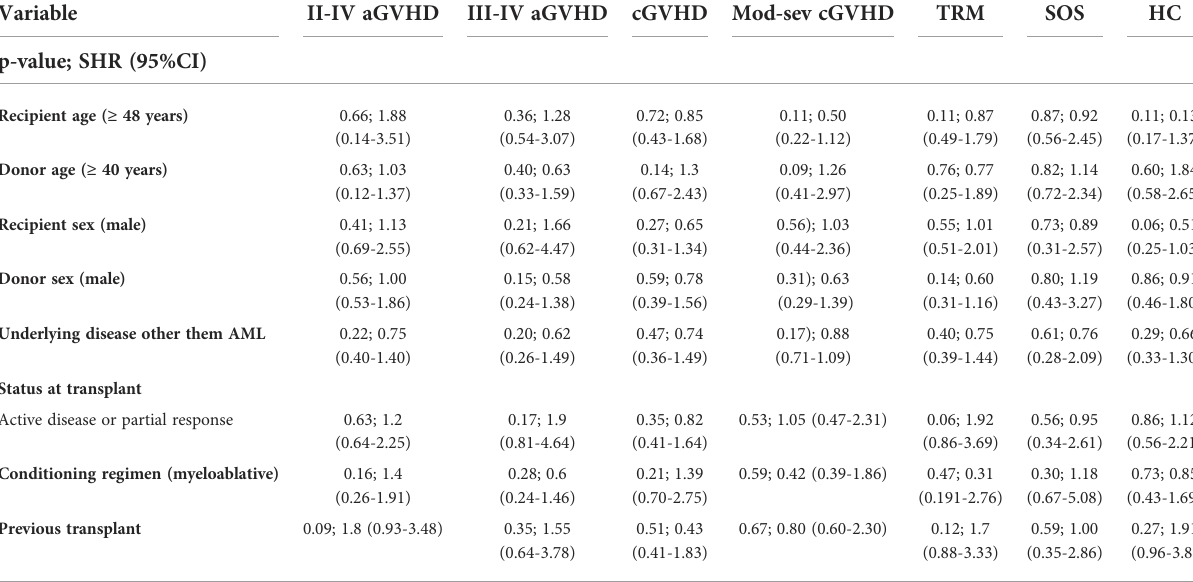
TABLE 2 Univariable analysis if the association between clinical variables and complications after Haplo-HSCT.